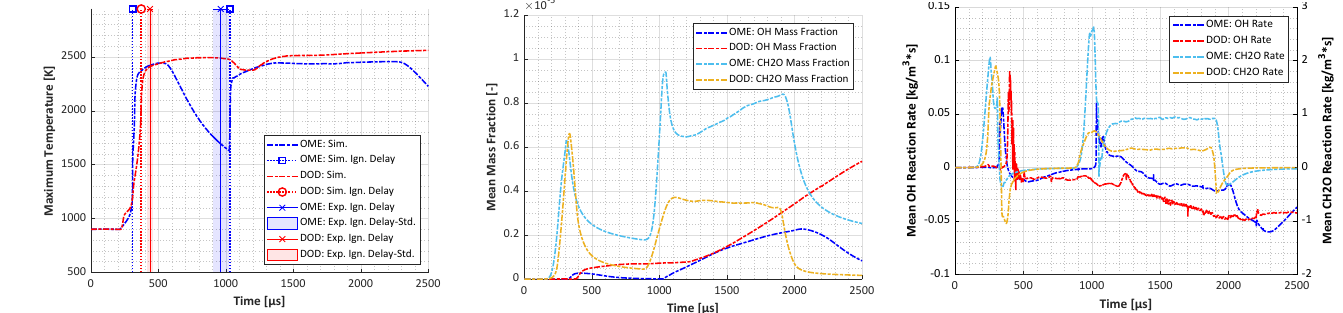
Figure 15. Conti3L ( ArM ): Time − resolved multi-injection profiles. ( left ) Maximum temperature. ( center ) Hydroxyl (OH) and Formaldehyde (CH 2 O) mass fractions. ( right ) Hydroxyl (OH) and Formaldehyde (CH 2 O) reaction